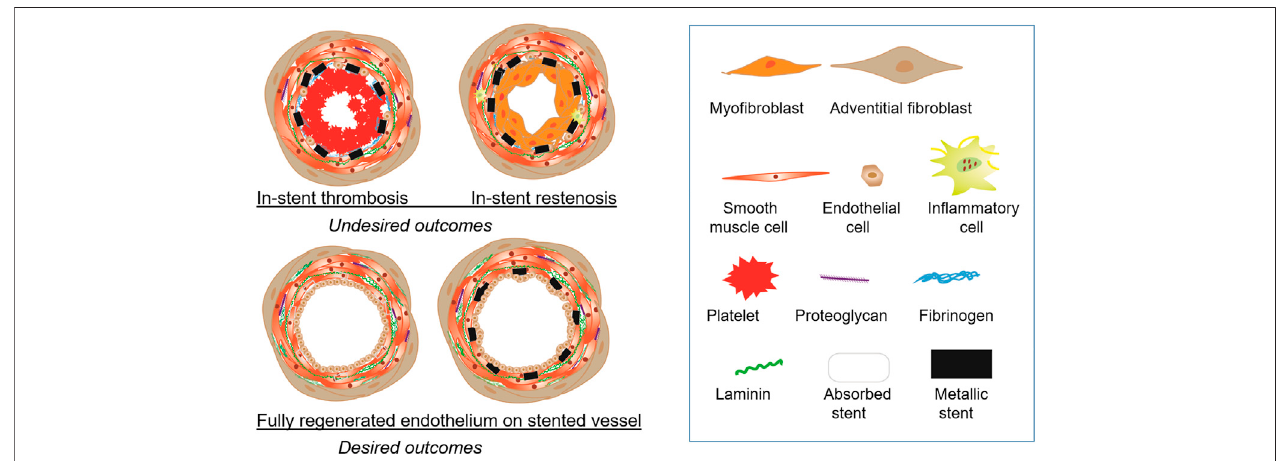
FIGURE 1 | Outcomes of endovascular stents. (Top panel) Stents produce undesired outcomes such as in-stent thrombosis and in-stent restenosis. In-stent thrombosis involves accumulation of platelets and presence of fi brinogen. In-stent restenosis causes narrowing ofthe lumen greater than 50% due to the overgrowth of smoothmusclecellswithneointimaformation.(Bottonpanel)Theidealvascularregenerationwithstentswillhaveafullydevelopedendothelialmonolayerliningthelumen with either the stent completely bioabsorbed or permanently encapsulated in the intimal